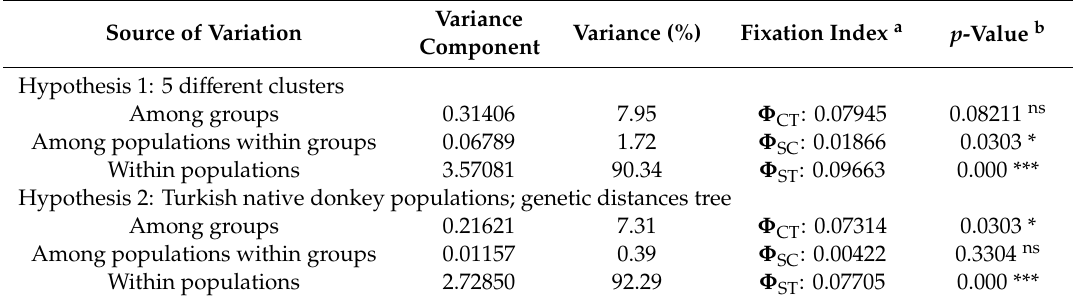
Table 7. The AMOVA analysis among the Turkish native donkey populations and 427 reference mtDNA D-loop